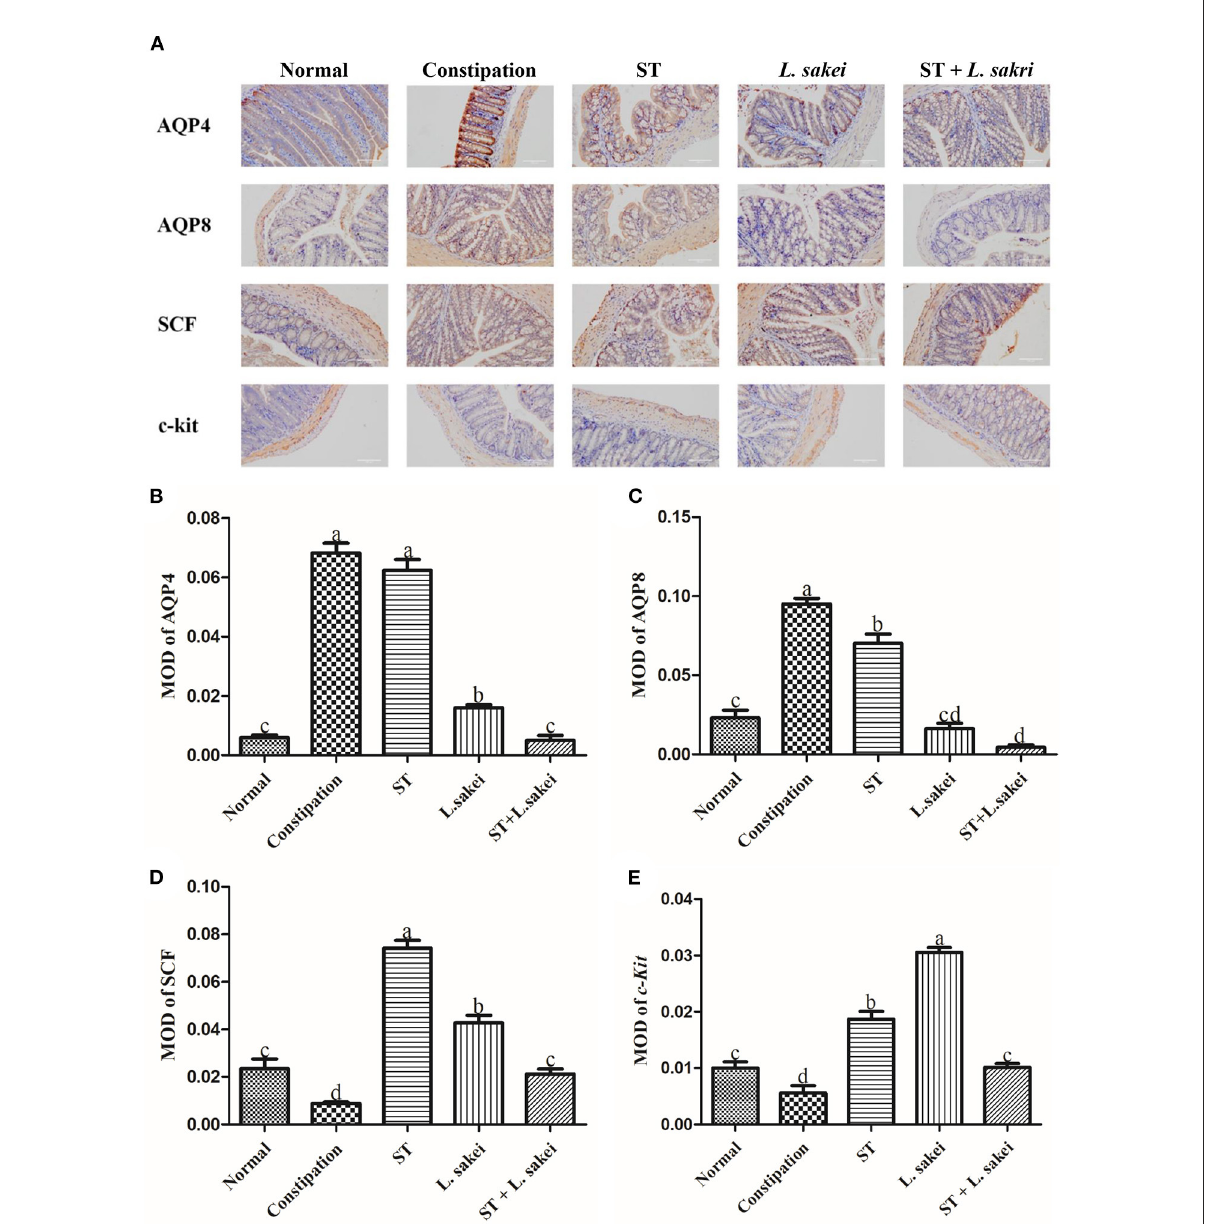
FIGURE3 The effect of ST or L. sakei alone or combined on the protein levels of constipation-related intestinal factors in mice. (A) Protein expressions of AQP4, AQP8, c-kit, and SCF in the colons of mice were detected by immunohistochemistry and were observed under a 200 × 00 microscope. The mean optical density (MOD) of AQP4 (B) , AQP8 (C) , c-kit (D) , and SCF (E) was calculated and evaluated by an experienced person who was blind to the samples in terms of treatment. Data represent the mean ± SD ( n = 6). Statistical analysis was conducted using One-way ANOVA followed by Tukey’s multiple comparisons test for each group using GraphPad Prism5. Bars bearing different letters indicate a significant difference, P < 0.05.